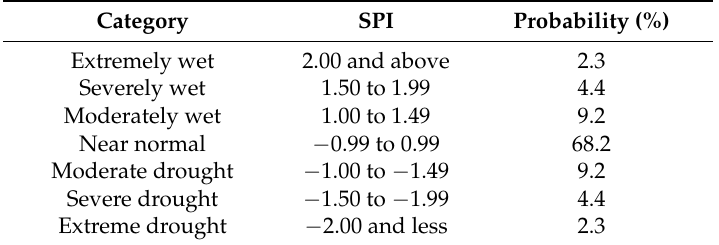
Table 1. Standardized precipitation index (SPI) categories based on initial classification of SPI